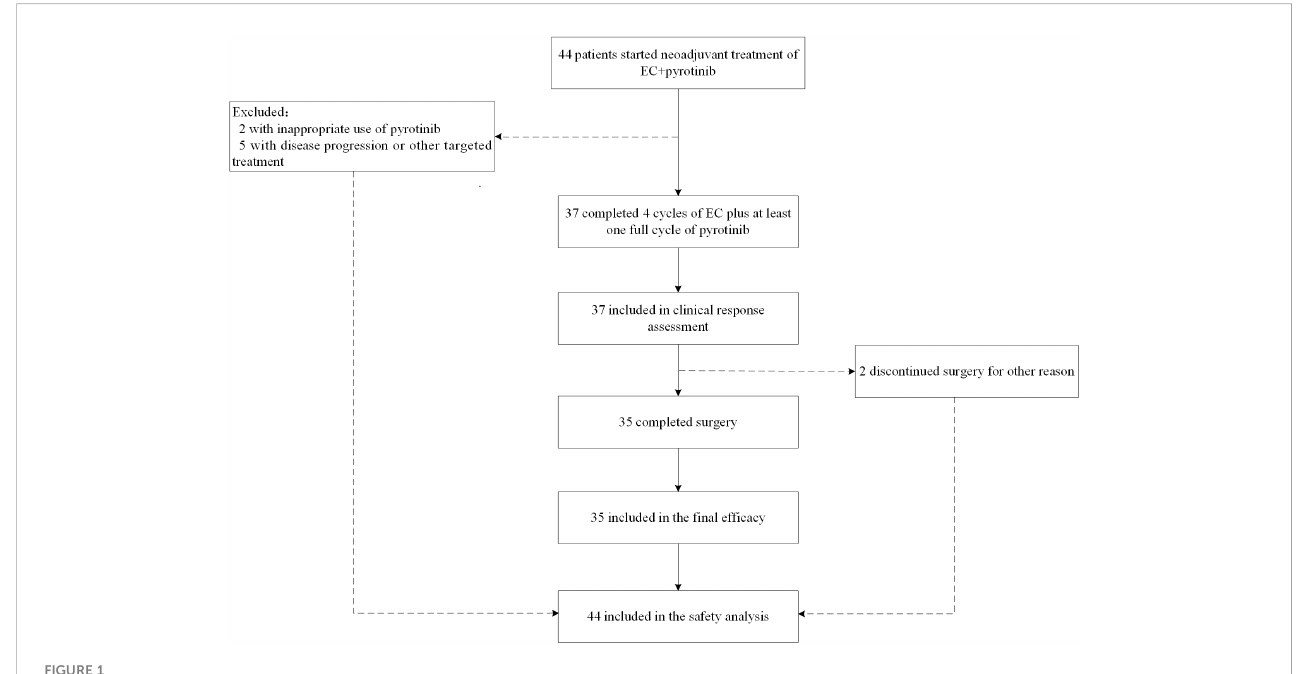
FIGURE 1 Trial pro fi